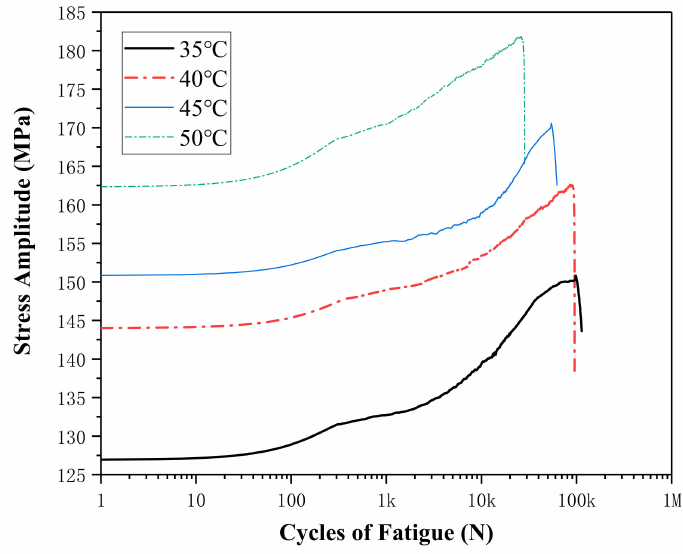
Figure 7. Stress amplitude curves at di ff erent temperatures for strain amplitude of